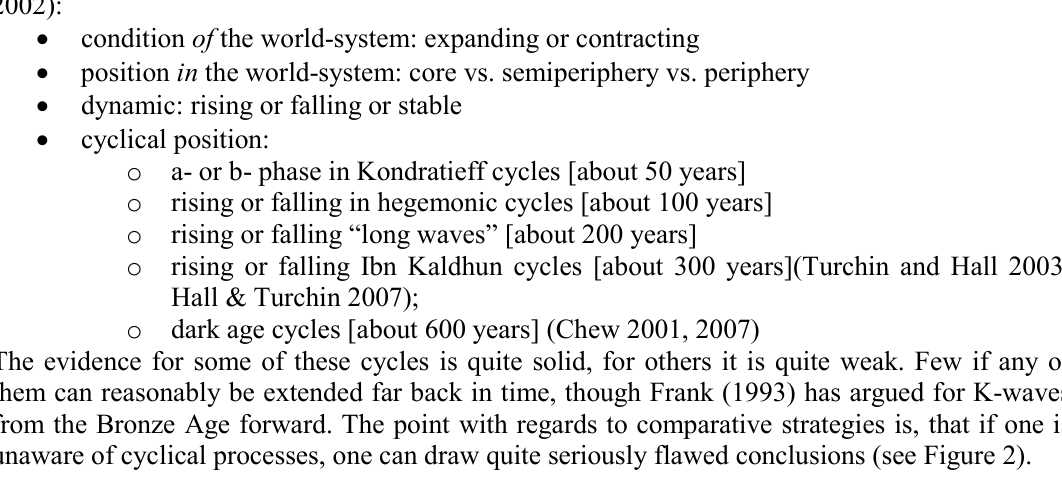
Figure 2: Secular Trend with Cycles: Possible